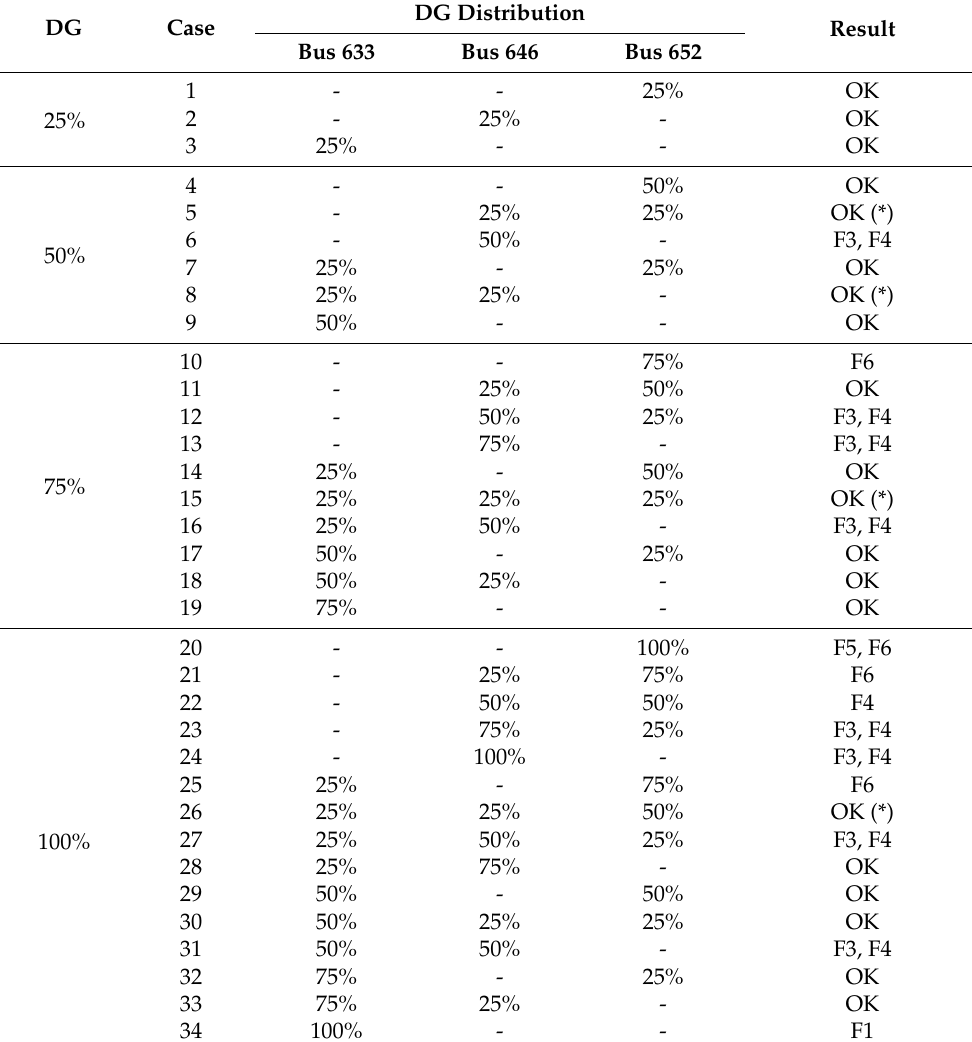
Table 7. IEEE 13-bus feeder system (Figure 6), simulated considering PQ nodes. The status result (either “OK” when no fuse was tripped, or including the unexpected tripped fuses) of the different cases related to DG power penetration level and its distribution among the 3 DG installed (bus nodes 633, 646, and 652) are included in the